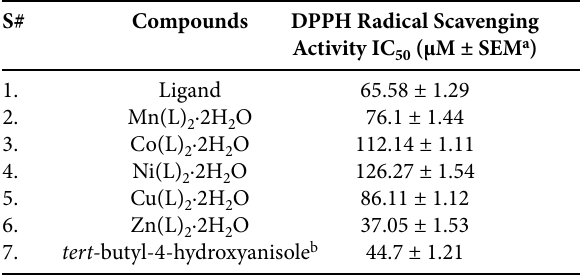
Table 2. Antioxidant Activity of Ligand and Respective